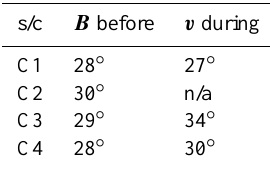
Table 1. The angle of coordinate rotation in the xy GSM plane that removes the correlation between B x 0 and B y 0 before the event, in- terval 03:00–03:25 UT, or between v x 0 and v y 0 during the